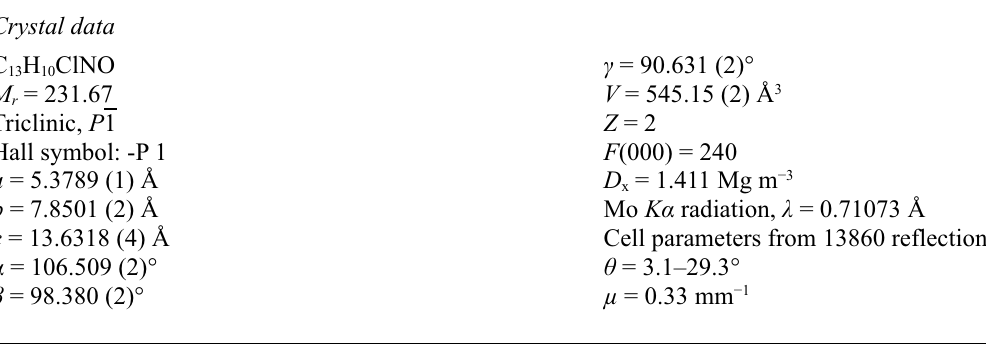
Part of the crystal structure of the title compound viewed down the b axis and showing infinite molecular chains in the[100] direction. H atoms not involved in intermolecular bonding have been omitted. [Symmetry code: (i) x + 1, y , z ] N -(4-Chlorophenyl)-benzamide Crystal